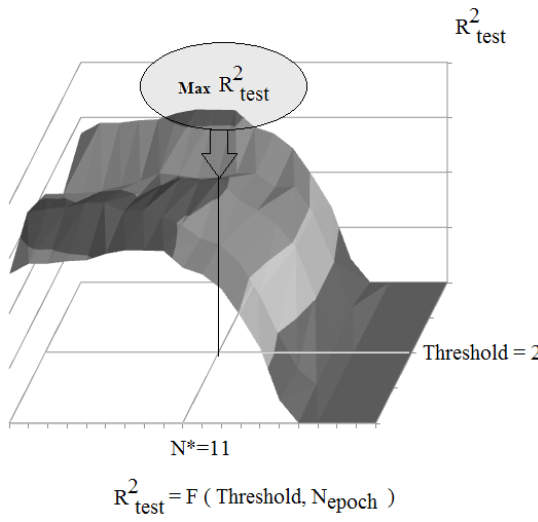
Figure 2. The correlation coefficient between experimental and calculated values of an endpoint for the external test set is a mathematical function of the threshold and the N . The N * is the number of epochs which gives the epoch maximum correlation coefficient for the external test